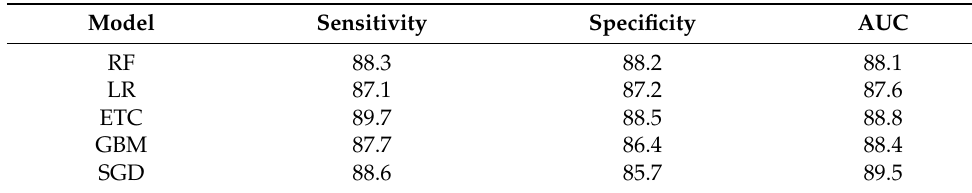
Table 6. Results of machine learning models for home tutoring scenario.